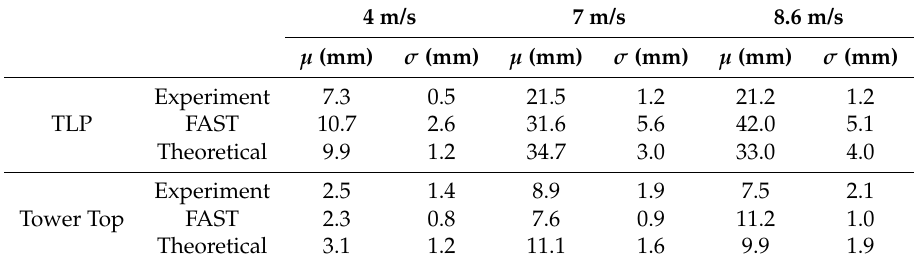
Table 8. The mean ( µ ) and standard deviation ( σ ) of the displacement in surge of the TLP and tower top at simultaneous wind and wave loading. The wind speeds which is tested at is 4 m/s, 7 m/s and 8.6 m/s and monocromatic waves with a wave height of 0.01 m and wave frequency of 1.7 Hz. 4 m/s 7 m/s 8.6 m/s µ (mm) σ (mm) µ (mm) σ (mm) µ (mm) σ